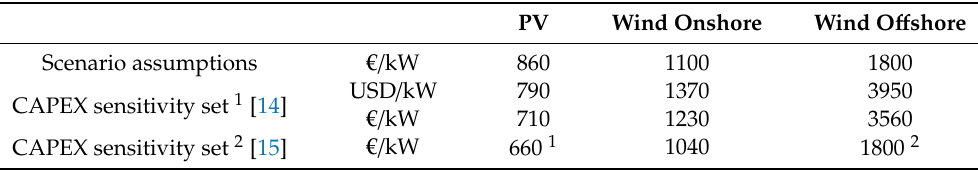
Table A9. Specific CAPEX sensitivity assumptions based on [48,49].